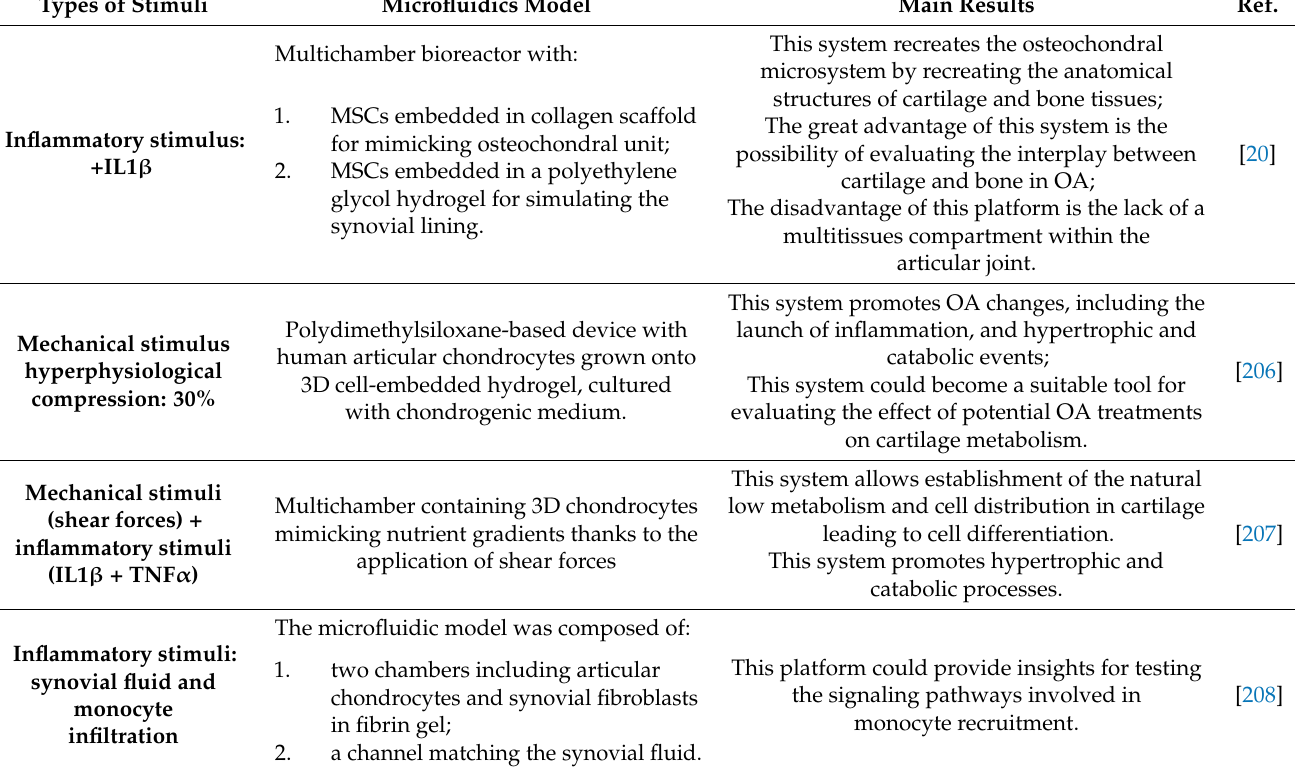
Table 3. List of some recent microfluidic models in OA with details of the kind of stimuli, the microfluidic model, the main findings, and the bibliographic references. Types of Stimuli Microfluidics Model Main Results